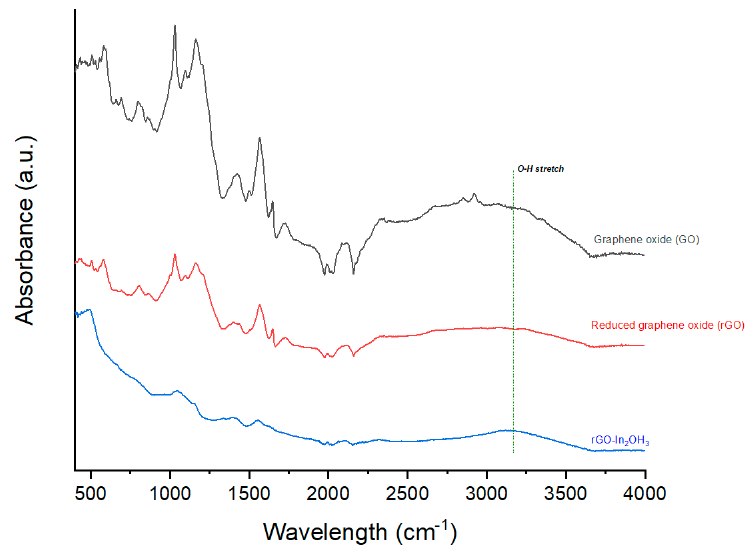
Figure 2. FTIR spectra of graphene oxide, reduced graphene oxide and indium-functionalized gra-